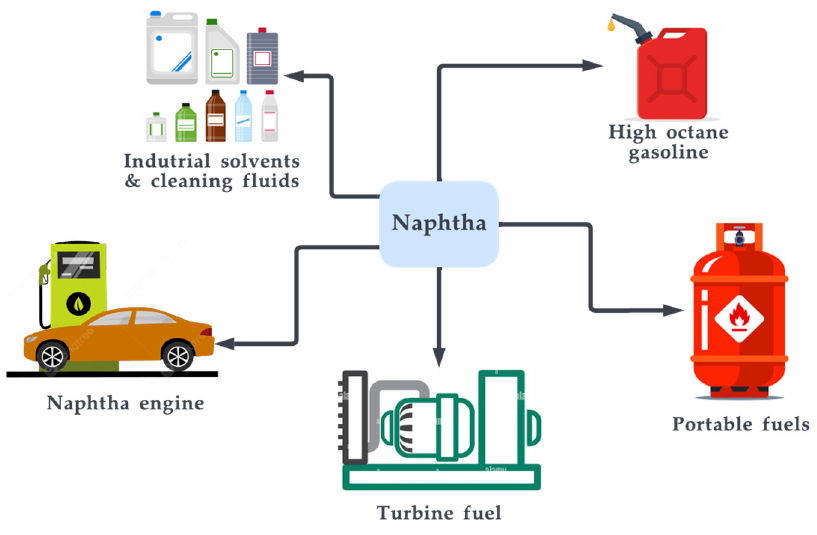
Figure 17. By-products of fractional distillation.